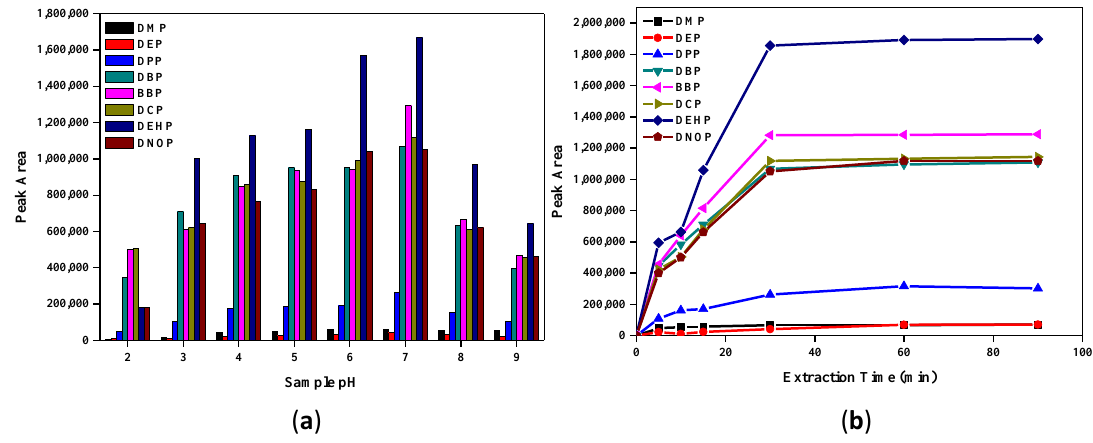
Figure 6. ( a ) Effect of sample pH; ( b ) effect of extraction time for the extraction of targeted